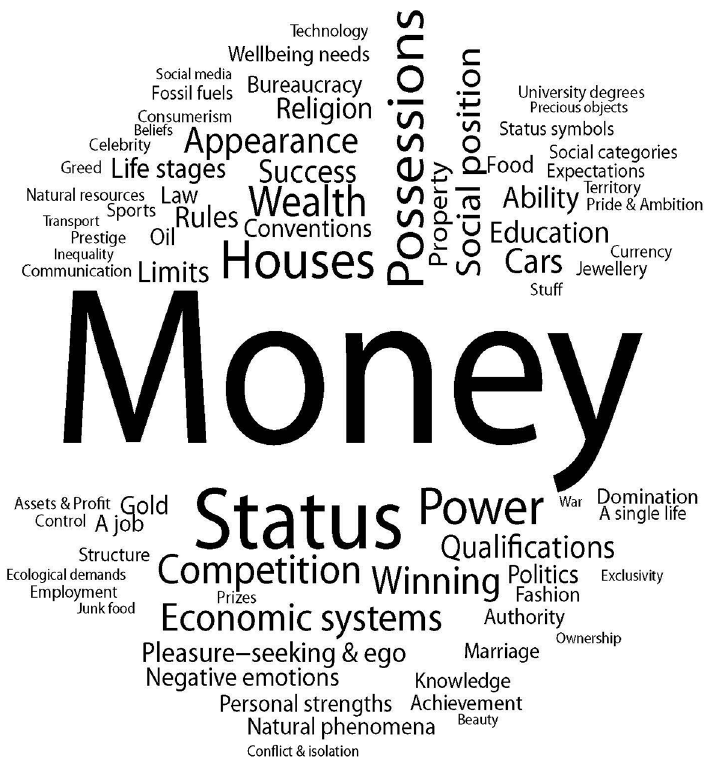
Figure 2. The finite word